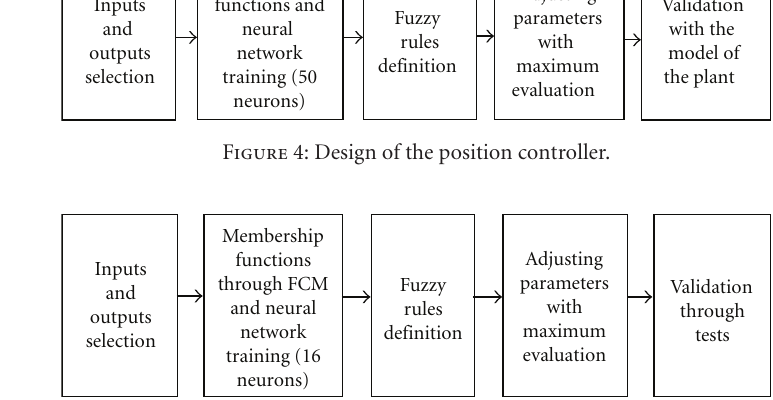
Figure 5: Design of the evasion controller.